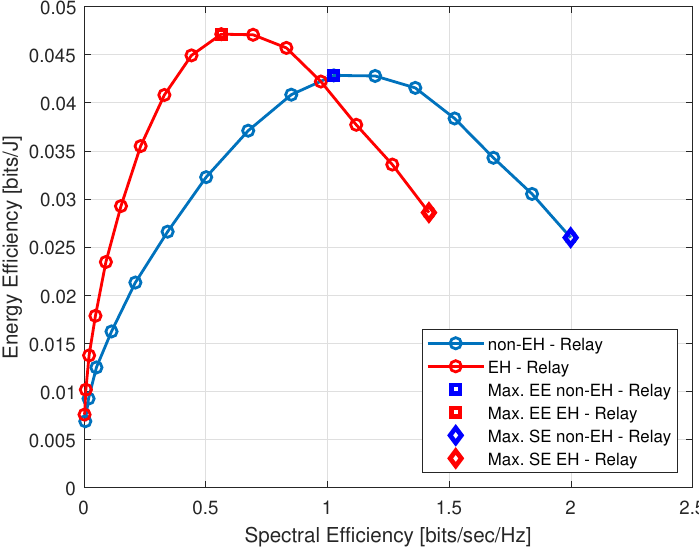
Figure 10. The SE-EE relationship for non-EH and EH relaying, N =